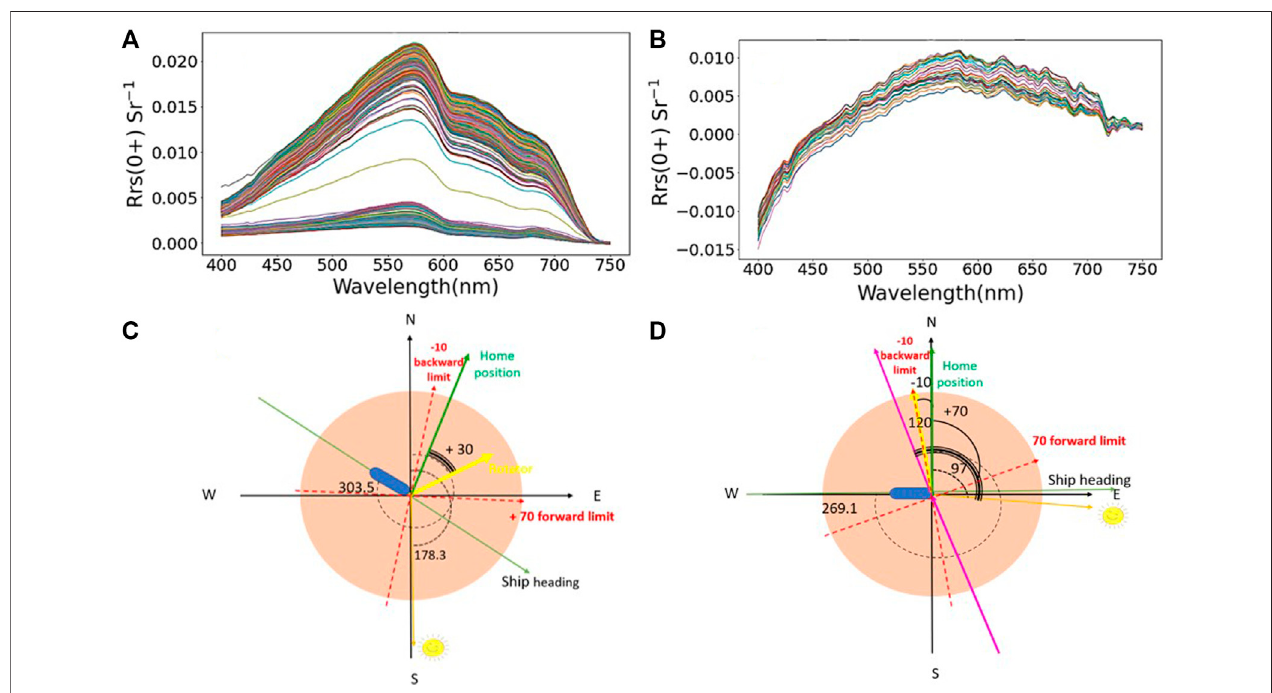
FIGURE3| R rs (0+)dataqualityassurance(QA)analysisresultsforthedatameasuredbySAS-STinstalledonferryQueenofAlbernion16June2019.Plotshowing R rs (0+) data for (A) noon trip; (B) morning trip data collection, and corresponding geometry with angle of acquisition for, (C) noon trip and (D) morning trip.